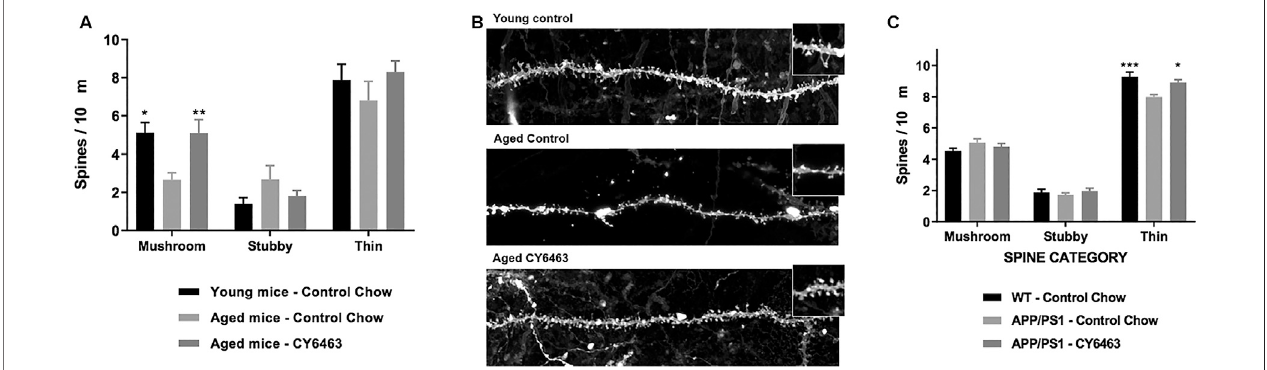
FIGURE 9 | Th density of mushroom, stubby, and thin dendritic spines in the hippocampus of mouse models of neurodegeneration. (A) , Spine densities in the hippocampus ofyoungmicetreatedwithcontrolchow,agedmice treatedwithcontrolchow,and agedmice treatedwithchowcontainingCY6463. (B) ,Representative imagesofhippocampal CA1 neurons apicalsecondarydendritesfromexperimentalgroups representedinA. (C) , Spinedensitiesinthehippocampus ofAPP/PS1mice treatedwithcontrolchoworwithchowcontainingCY6463,andwild-type(WT)littermatecontrolstreatedwithcontrolchow.AllannotatedDunnet ’ sposthoctests were performed after signi fi cant main effects or interactions in ANOVA analysis: *p,0.05, **p,0.01, ***p,0.001. All data are expressed as mean ±